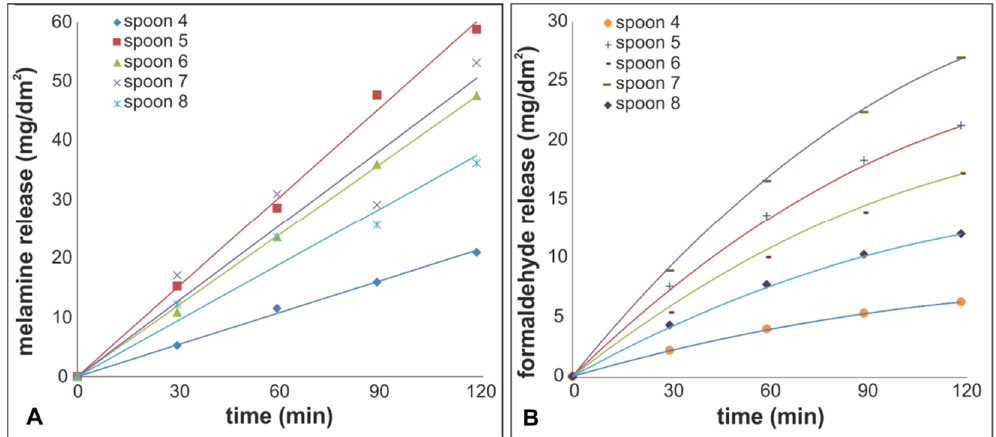
Figure 4. Time dependent measurement of the third release (3% acetic acid, hot plate, stirring), ( A ) melamine, solid lines: linear fit of data; ( B ) formaldehyde, solid curves: formaldehyde in solution, evaporation losses calculated with an evaporation rate of 0.83%/min